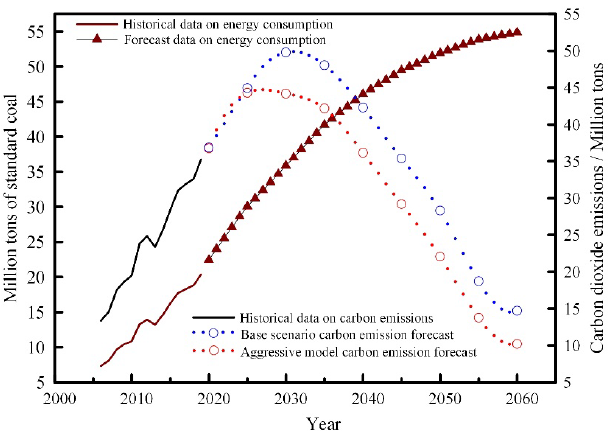
Figure 9. Carbon emission forecast for rural household energy consumption in Guangdong under different models. different